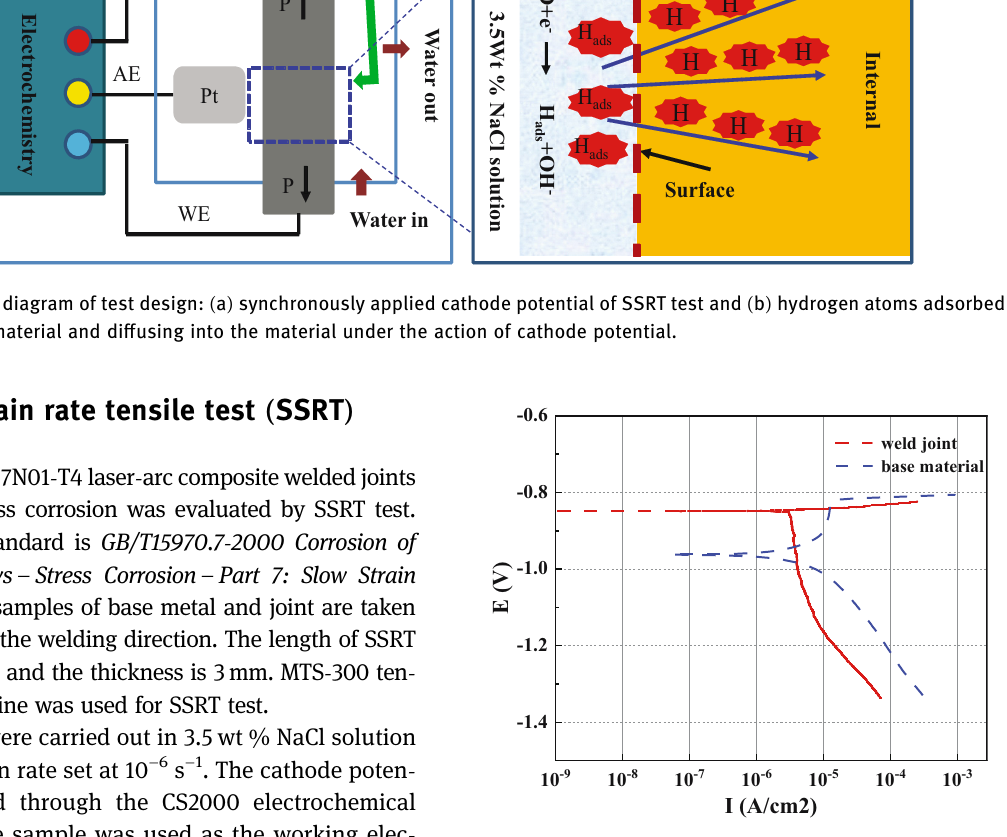
Figure 2: Polarization curves of 7N01 - T4 aluminum alloy base metal and joint weld